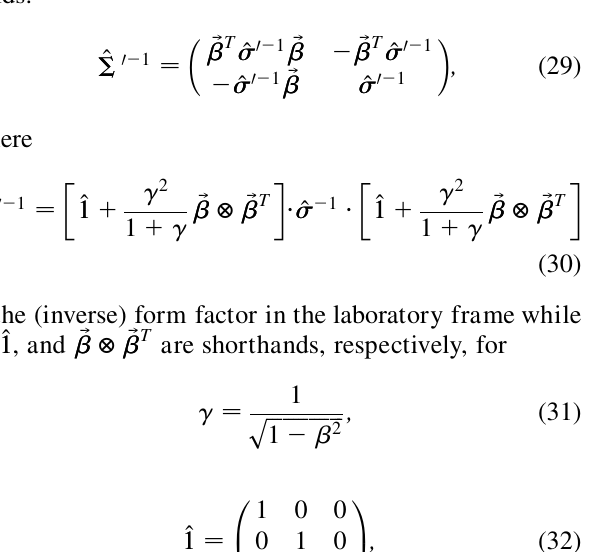
FIG. 3. Relative effective field as a function of R for a macroparticle with Gaussian and ‘‘hard spheroid’’ (solid and dashed lines, respectively) form